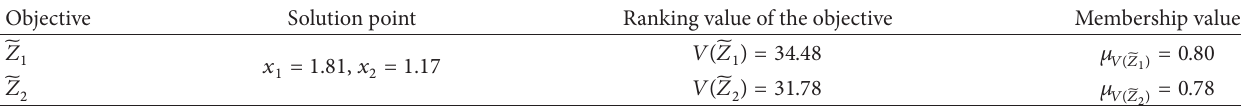
Table 2: Compromise solution obtained by proposed methodology.